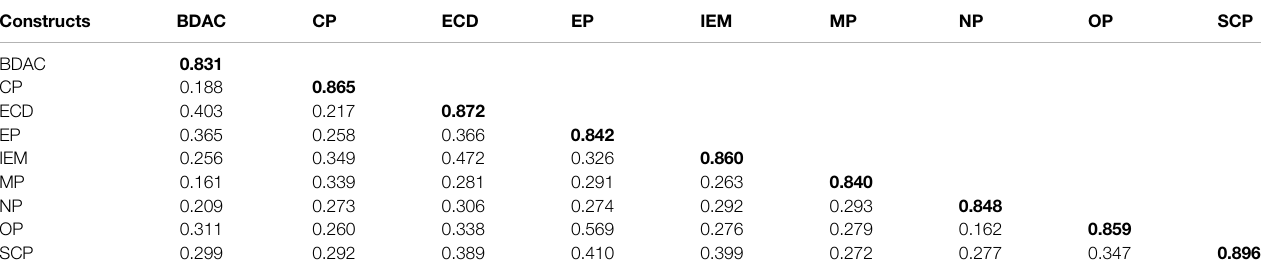
TABLE 3 | Fornell-Larcker criterion.